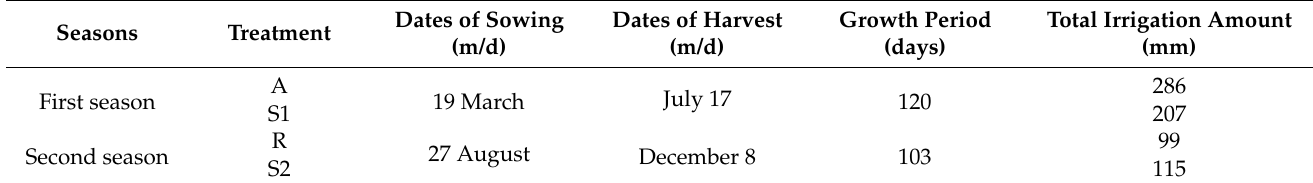
Table 1. Dates of sowing and harvest as well as irrigation amount during two growing seasons of potato.